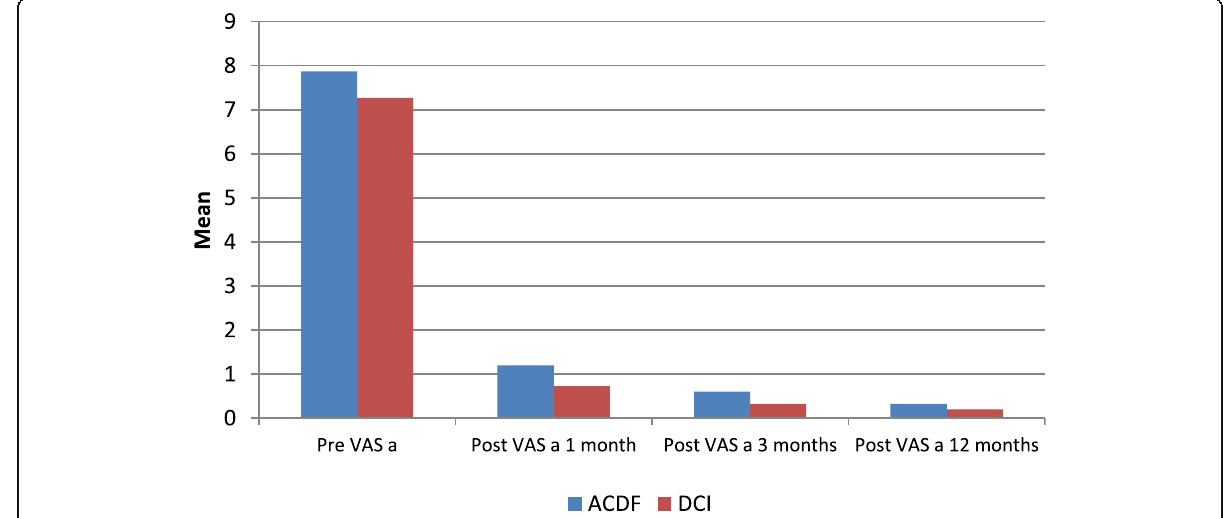
Fig. 2 Visual analogue score for the arm pain recorded preoperatively and at 1, 3, and 12 months postoperatively for both groups